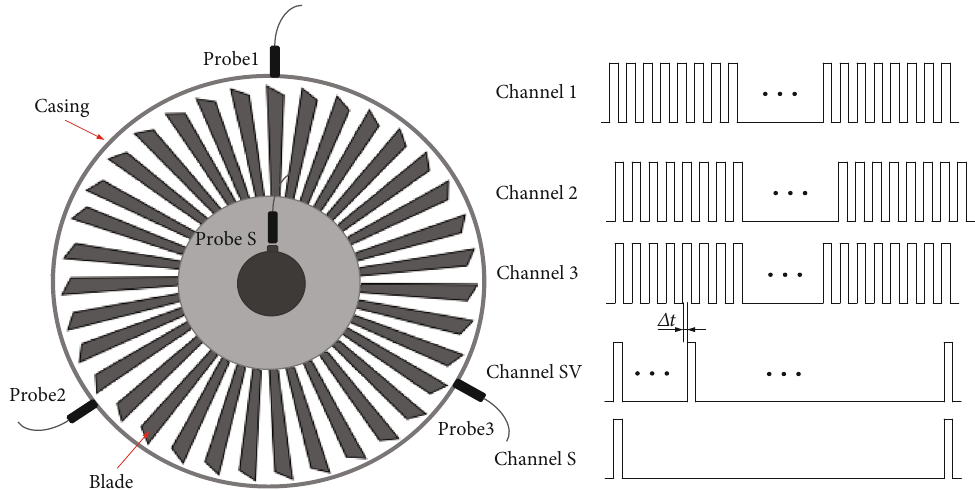
Figure 1: Measurement principle of blade tip timing systems.